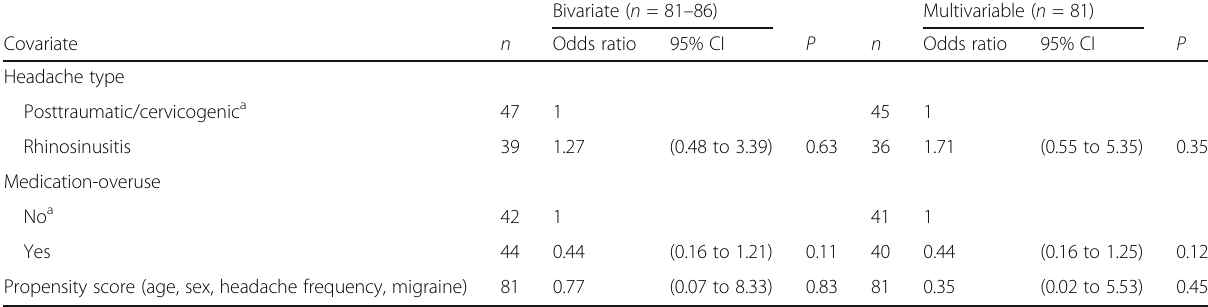
Table 5 Odds for having EDS, defined as ESS > 10. Penalized maximum likelihood logistic regression Bivariate ( n = 81 – 86) Multivariable ( n = 81) Covariate n Odds ratio 95% CI n Odds